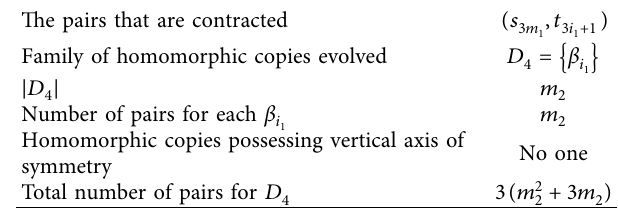
Table 1: Necessary information regarding homomorphic copies ′ 􏽮 􏽯 . α i 2